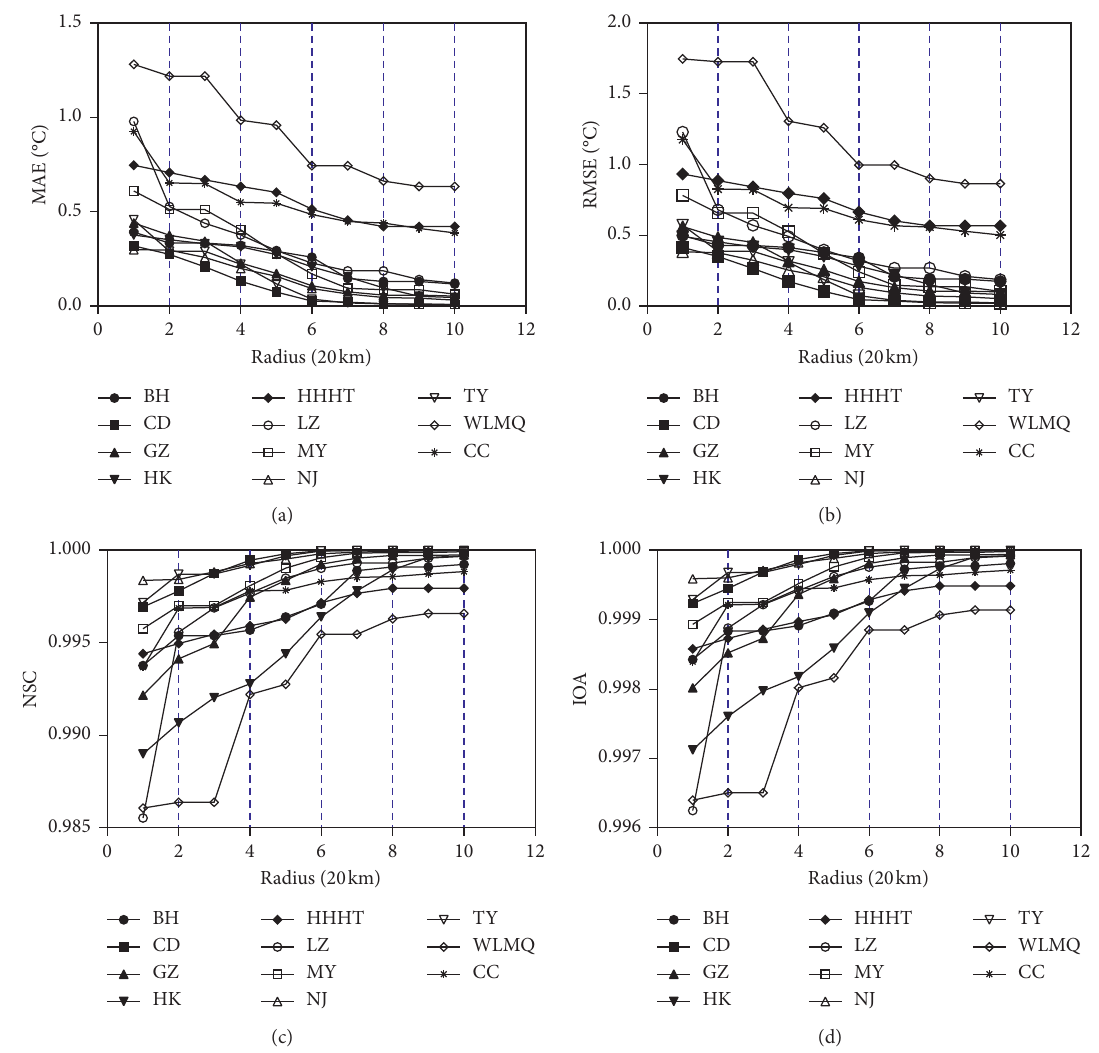
Figure 3: Comparison of various indicators with the increasing radius in different regions: (a) MAE; (b) RMSE; (c) NSC; (d)